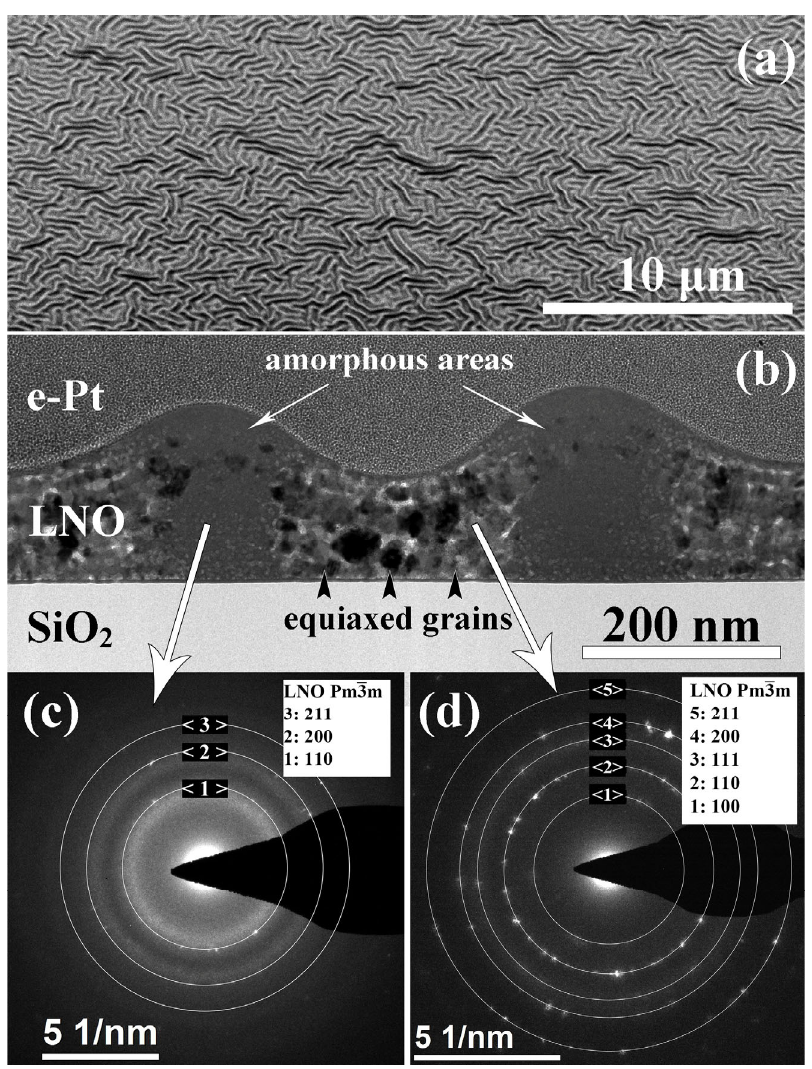
Figure 1. Microstructure of the cross section of LNO ‐ cryst ‐ 2min sample: SEM image of the surface at the angle of 52° ( a ); bright ‐ field TEM image ( b ), electron diffraction patterns from the amor ‐ the angle of 52 ◦ ( a ); bright-field TEM image ( b ), electron diffraction patterns from the amorphous phous ( c ) and crystalline ( d ) regions. ( c ) and crystalline ( d )